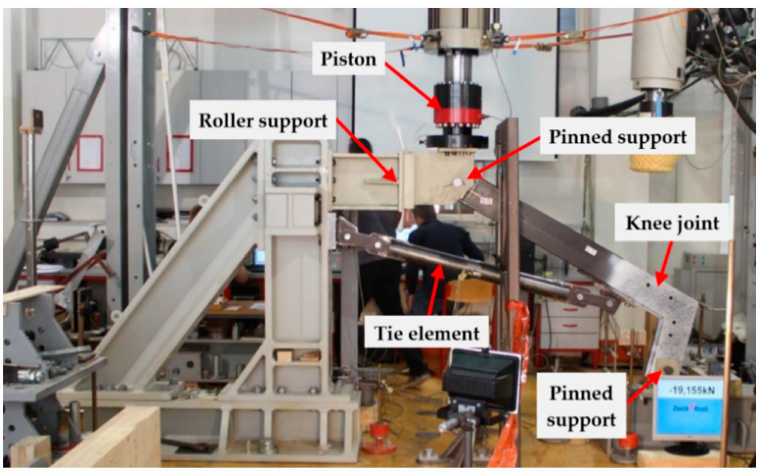
Figure 1. Test setup—a general